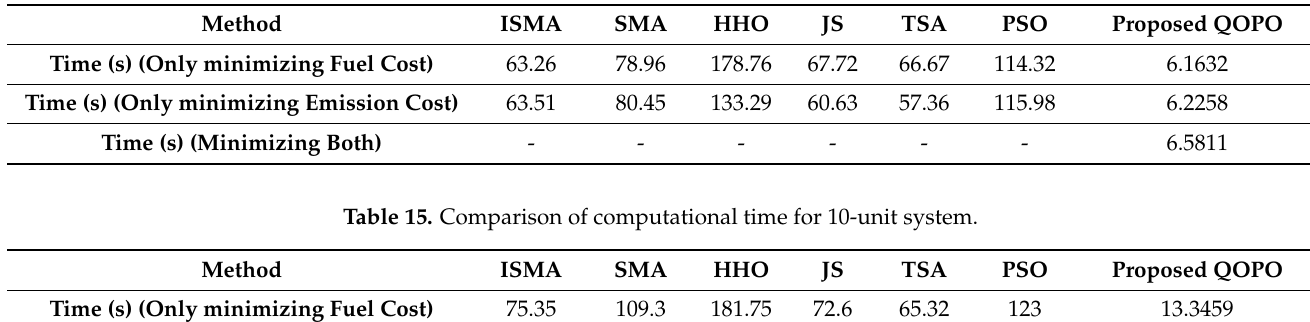
Table 14. Comparison of computational time for a six-unit system for the load demand of 2.834 MW.